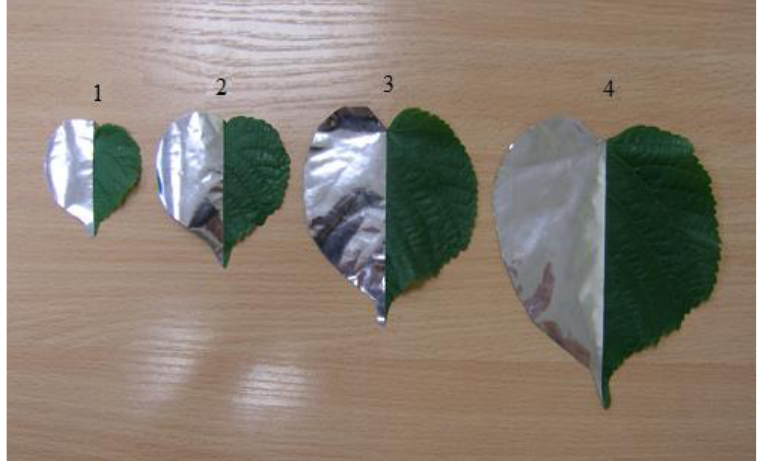
Figure 2. Broadleaf linden leaves ( Tilia platyphyllos Scop ): 1 — leaf area 9.2 ± 0.6 cm 2 ; 2 — leaf area 16.0 ± 0.8 cm 2 ; 3 — leaf area 29.1 ± 1.1 cm 2 ; 4 — leaf area 52.5 ± 1.9 cm 2 .